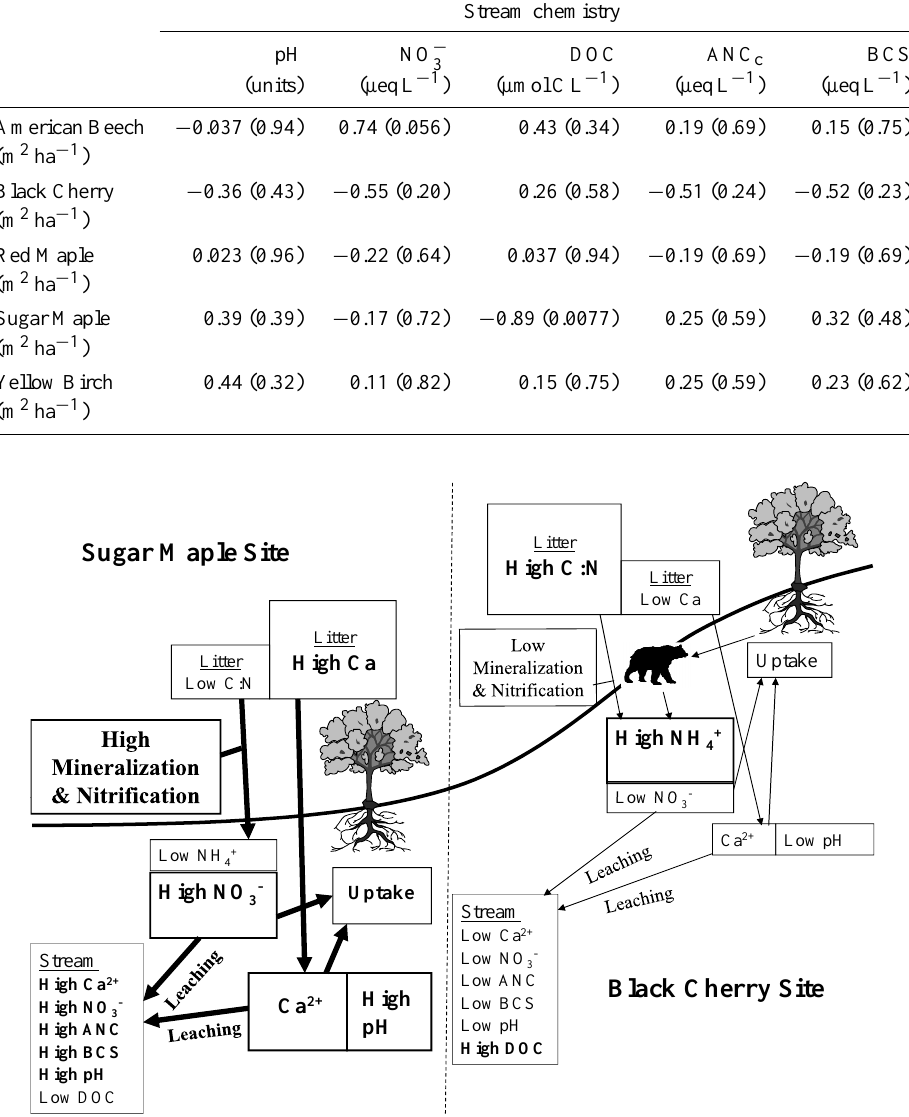
Table 4. Factor analysis. Watershed average stream chemistry data and tree species basal area Pearson correlation coefficients ( n =7) with p values.